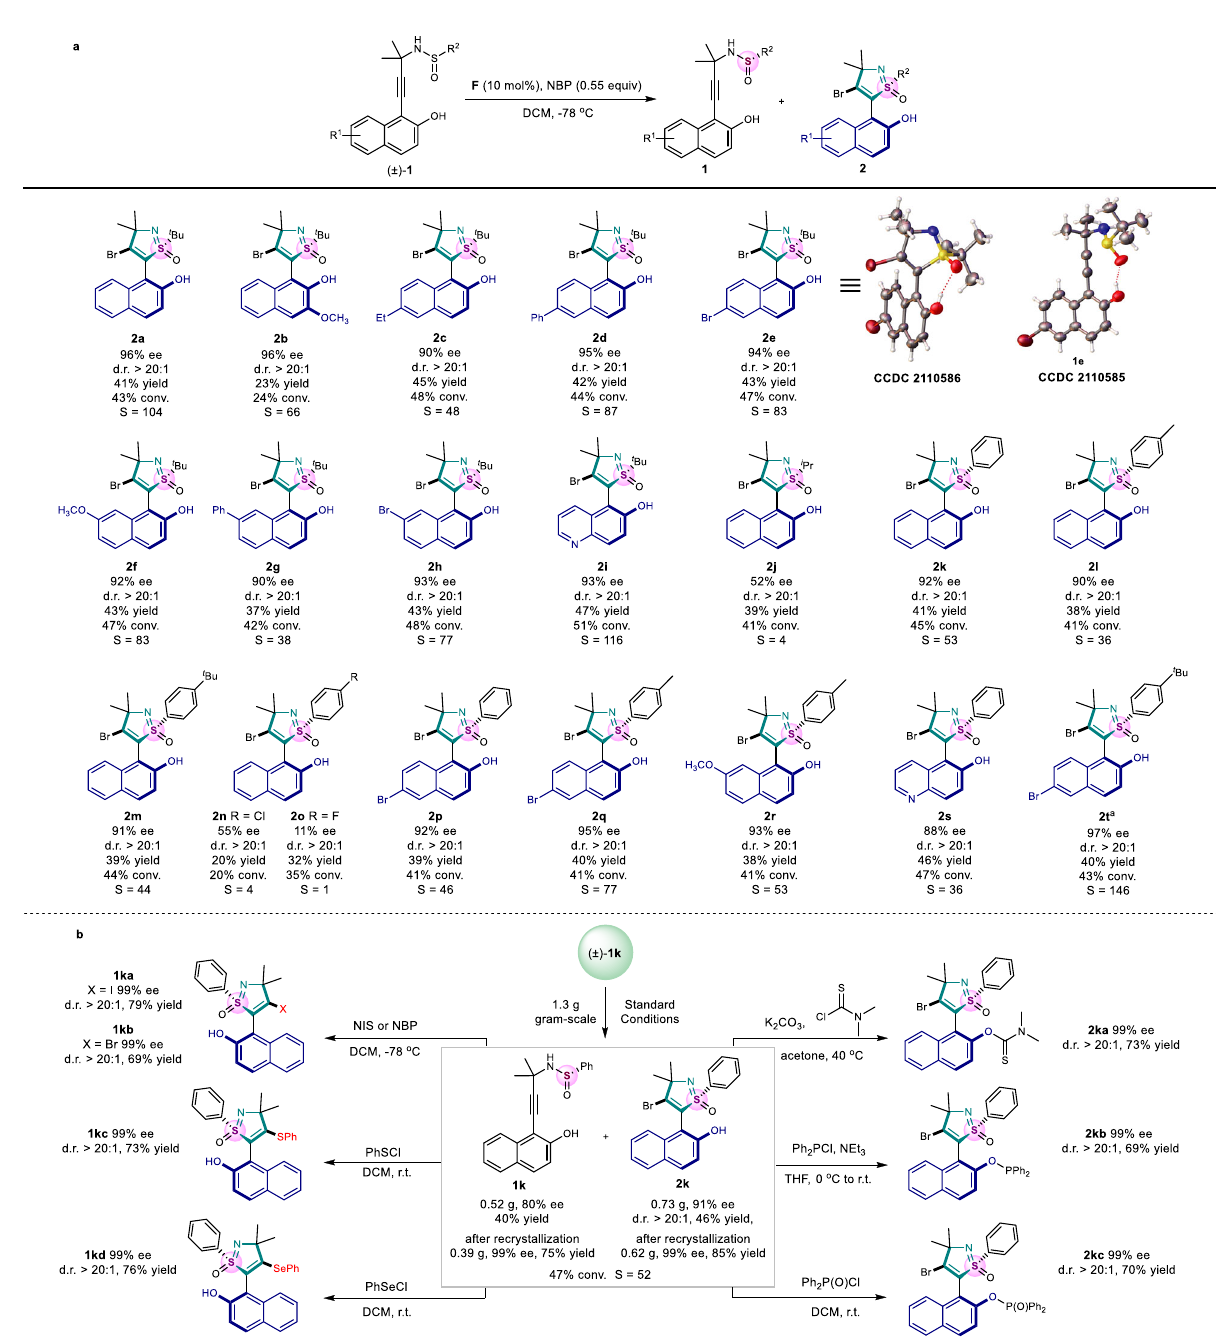
Fig. 3 Substrate scope of naphthyl-isothiazole S-oxides and synthetic transformations. a Substrate scope of naphthyl-isothiazole S-oxides. Reaction conditions: (±) − 1 (0.3 mmol), F (10 mol%) in DCM (12.0 mL) at − 78 °C for 10 min, then NBP (0.165 mmol) were added; Enantiomeric excess (ee) were determined by HPLC; Diastereomeric ratio (d.r.) was determined by HPLC; Isolated yield; Conversion ratio was calculated by the methods of Fiaud: conv. = ee 1 /(ee 1 + ee 2 ). Selectivity values were calculated by the methods of Fiaud: S = ln[(1 – conv.)(1 – ee 1 )]/ln[(1 – conv.)(1 + ee 1 )], unless otherwise speci fi ed. a F (20 mol%). b Gram-scale reaction and synthetic transformations (NIS: N -Iodosuccinimide). t Bu tert -Butyl, i Pr